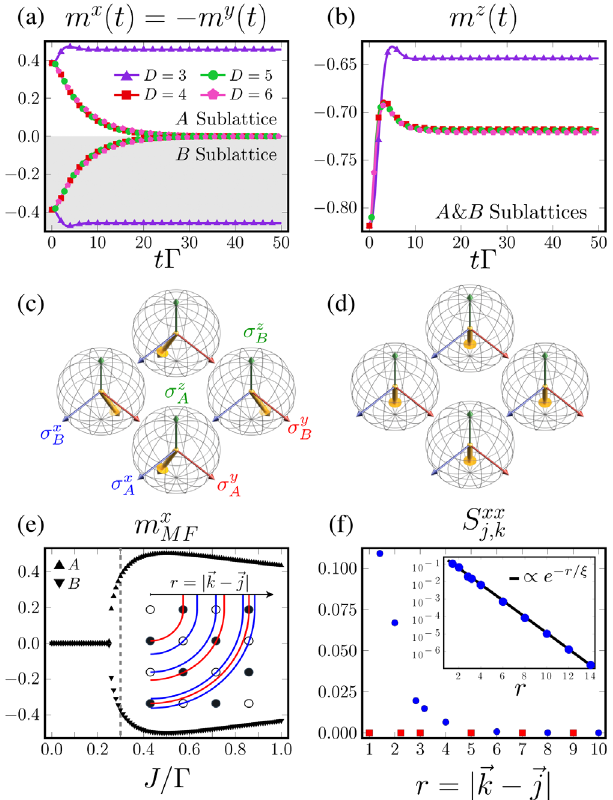
FIG. 7. Fate of staggered- XY phase at J= Γ ¼ 0 . 3 . (a,b) Local magnetizations m x;y;z ð t Þ on the A and B sublattices as the state evolves from the D ¼ 1 steady-state solution for bond dimen- sions D ∈ ½ 3 ; 4 ; 5 ; 6 (cid:2) . (c,d) Representation of a 2 × 2 plaquette of the lattice in (c) the staggered- XY phase ( D ¼ 1 steady state) and (d) the uniform phase ( D ¼ 6 steady state). (e) Mean-field phase ⃗ k − ⃗ j j of an diagram with a transition at J= Γ ¼ 1 . Inset: radii r ¼ j 4 odd (red) and even (blue) number of steps on the lattice. σ x (f) Correlation function S xx ¼ h σ x i versus distance r , which j j;k k has a staggered form that is a remnant of the staggered- XY phase. Correlations at odd step radii (red squares) are zero, and those at even step radii (blue circles) are finite and decay with r . Inset: exponential fit to even step correlations, giving a correlation length ξ ≈ 0 . 93